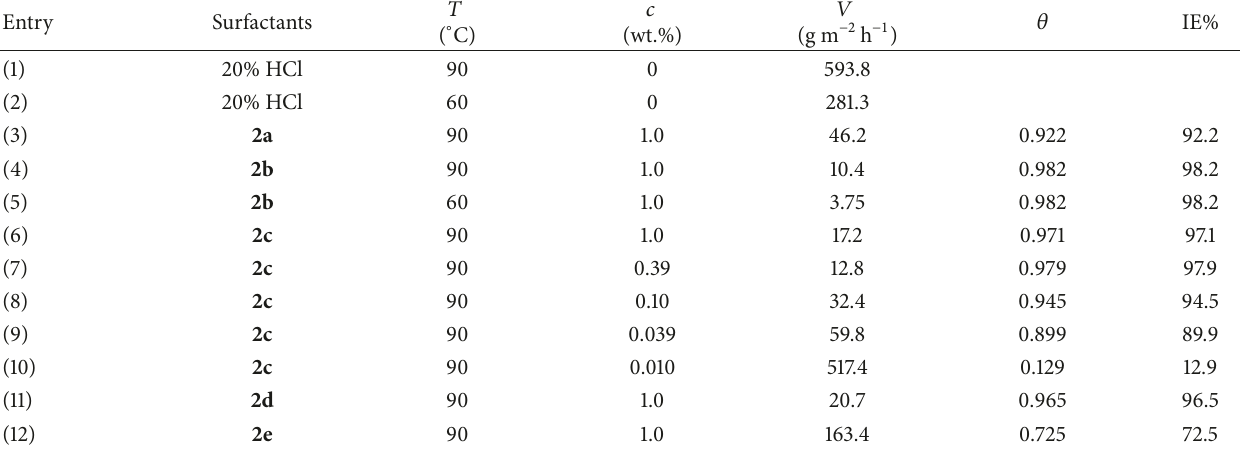
Table 2: Weight loss results for N80 steel in 20wt.% HCl in the absence and presence of inhibitor for 4h. Entry